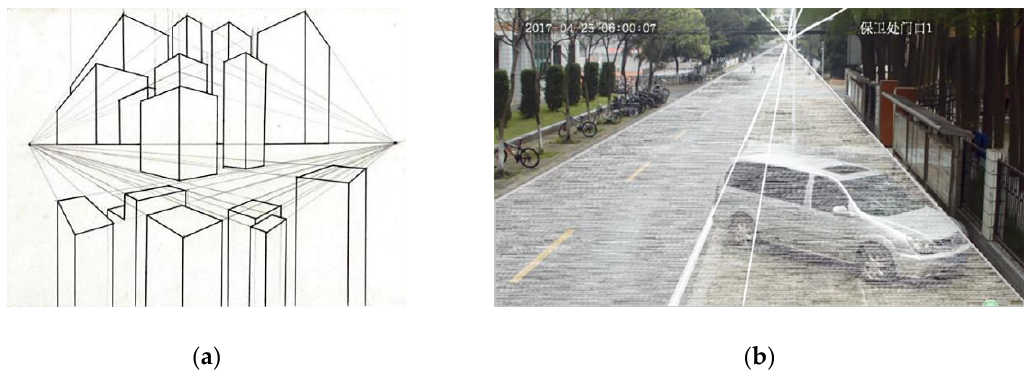
Figure 6. Linear perspective: the performance of linear perspective in theory ( a ) and in the real image ( b ). In Figure 6b, the straight lines of the road converge on one point, which is defined as Vanishing Point (VP). The lines that cross the vanishing point are defined as Vanishing Lines (VL). Based on the